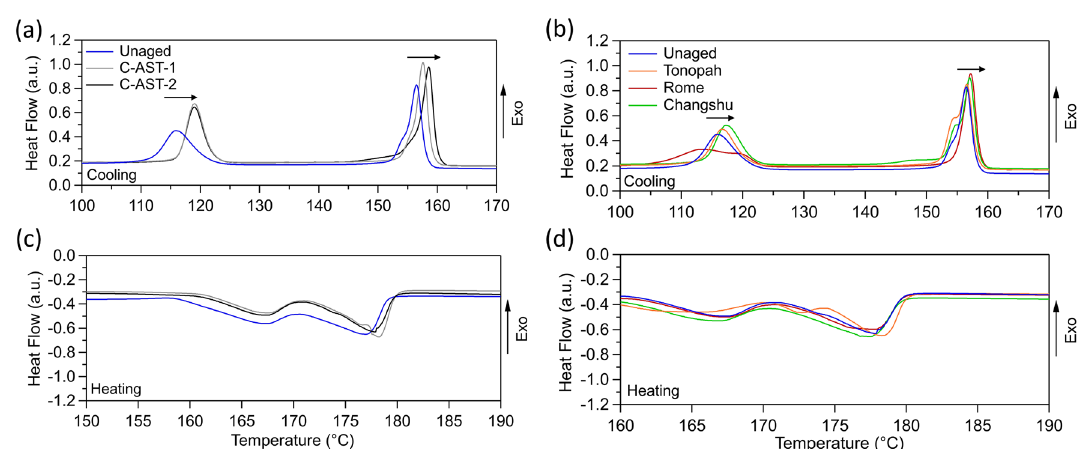
Figure 7. DSC heat flow for ( a ) first cooling cycle for unaged and C-AST-aged AAA samples, ( b ) first cooling cycle for unaged and field-aged samples, ( c ) first heating cycle for unaged and C-AST-aged samples and ( d ) first heating cycle for unaged and field-aged samples. Arrows indicate trends of the key thermal transition